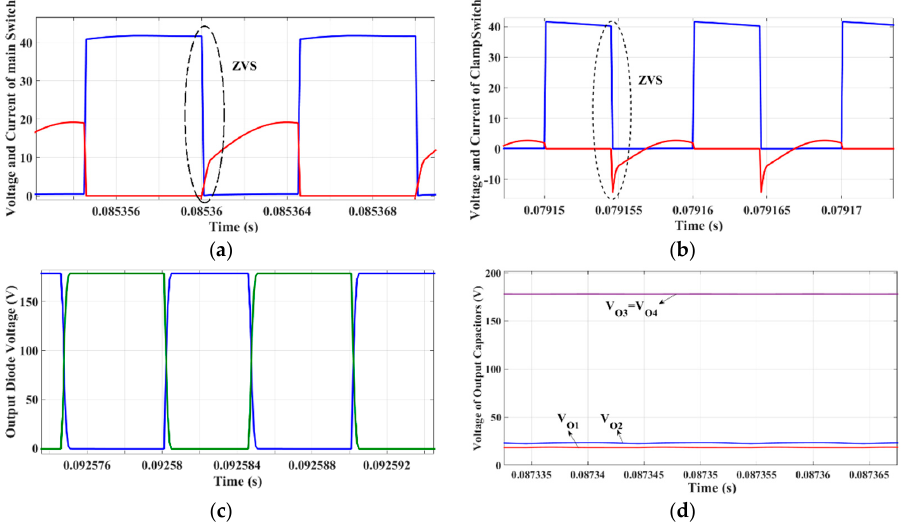
Figure 10. Simulation results during light loading when P = 100 W, D = 0.45, V in = 22 V, and V o = 400 V. ( a ) Voltage and current of the main switch; ( b ) voltage and current of the clamp switch. ( c ) voltage of the output diodes V Do1 and V DO2 ; and ( d ) voltage of the output capacitors V o1 –V o4 .